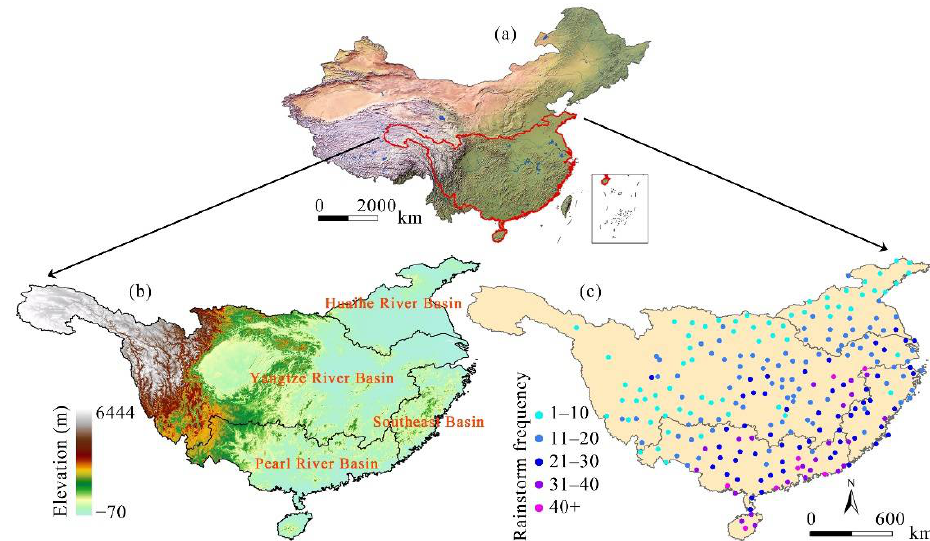
Figure 1. ( a ) The location of the study area in China, ( b ) the study area’s DEM and basins, ( c ) the rainstorm frequency distribution in the study area from 2015 to 2018.